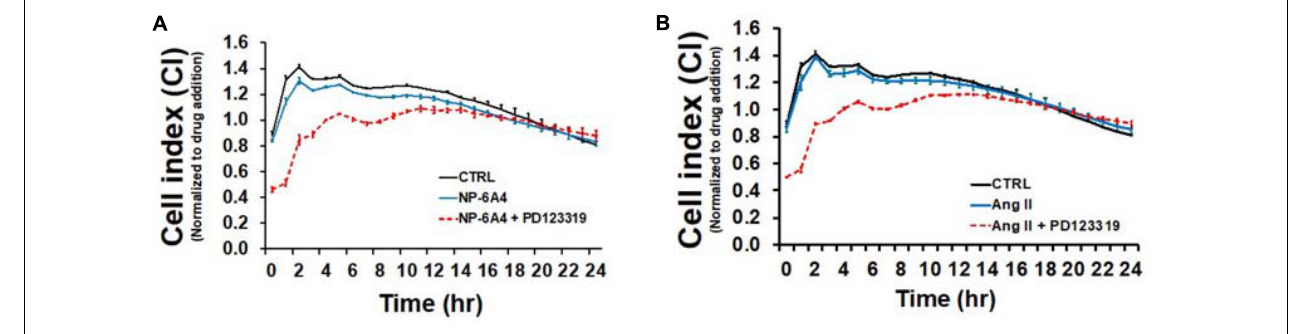
FIGURE 6 | Growth promoting effects of NP-6A4 are similar to Angiotensin II in hCAECs. (A) NP-6A4 did not increase CI in hCAEC, while AT2R-agonist PD123319 decreased CI initially but stabilized within 24-h. (B) Likewise, Ang II did not change CI compared to normal medium, while PD123319 attenuated CI at 6 h post treatment but stabilized within 24-h. n = 4. Control data is the same in A and B. CI, cell index; Ang II, angiotensin II; hCAECs, human coronary artery endothelial